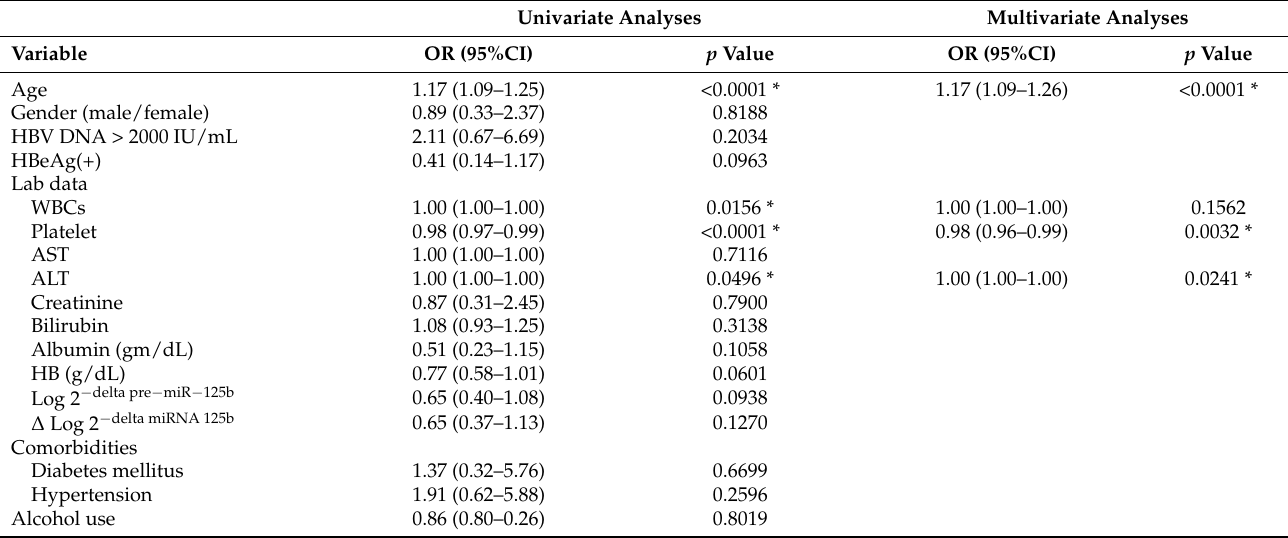
Table 2. Predictor of 12M FIB-4 index